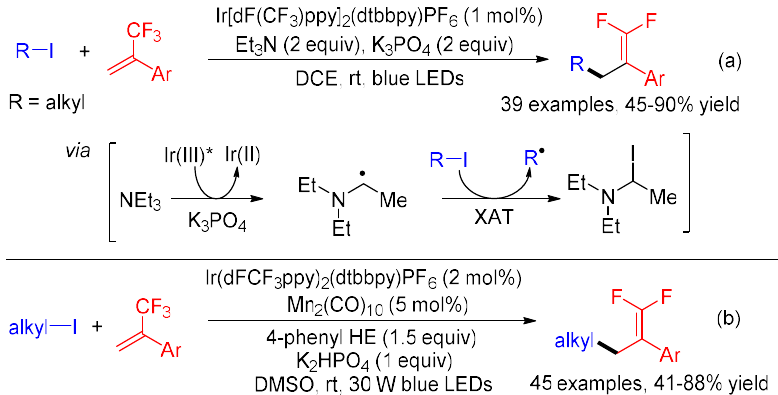
Scheme 32. Redox neutral γ,γ-difluoroallylation of cycloketone oxime